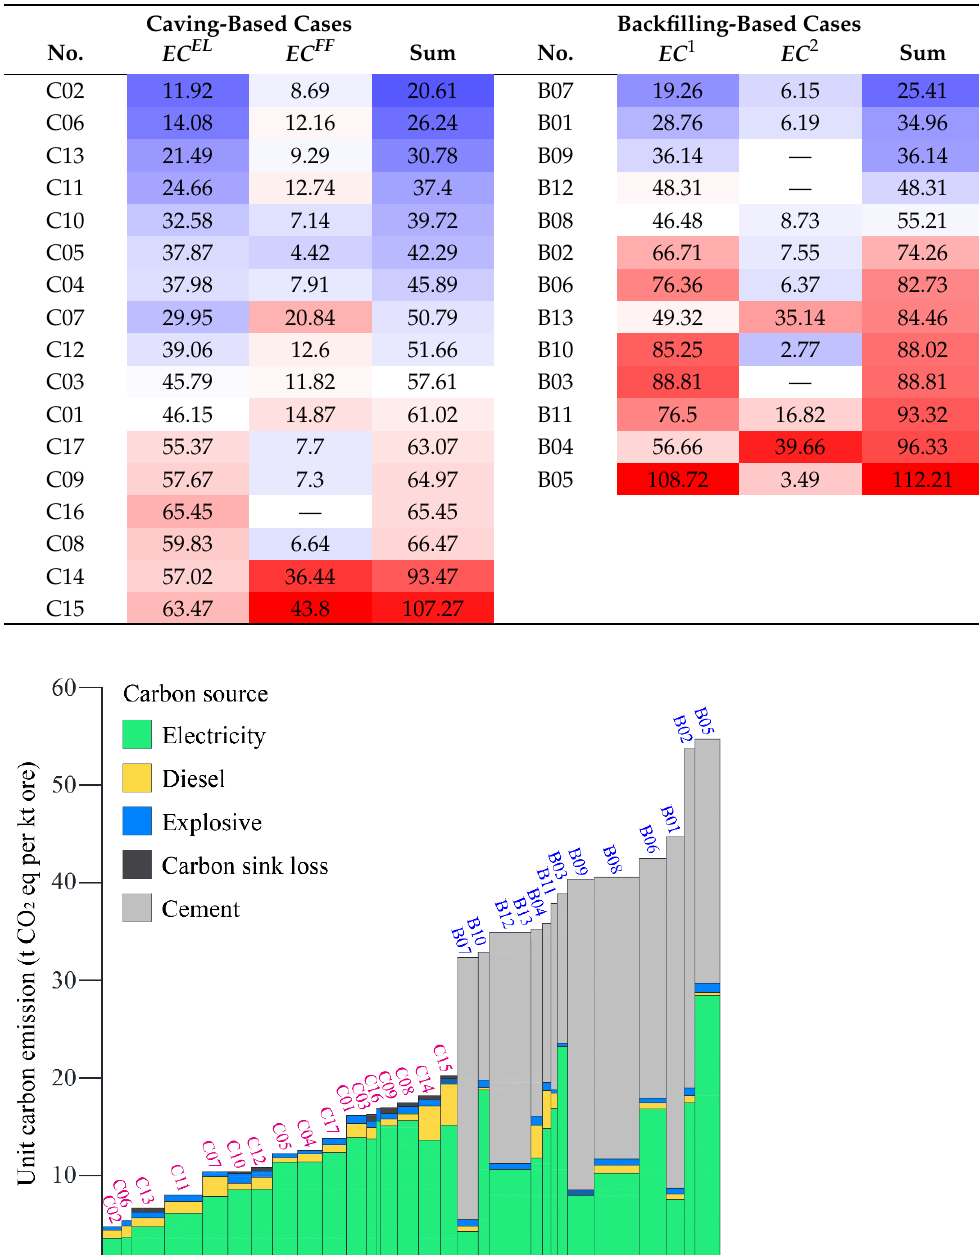
Table 2. Energy consumption without the consideration of industrial explosives. The results are colored by red and blue in varying intensity to indicate the difference between the results of each case and the average overall, i.e., 46.42, 10.67, and 57.09 GJ/kt for EC EL , EC FF , and sum of EC EL and EC FF , respectively.